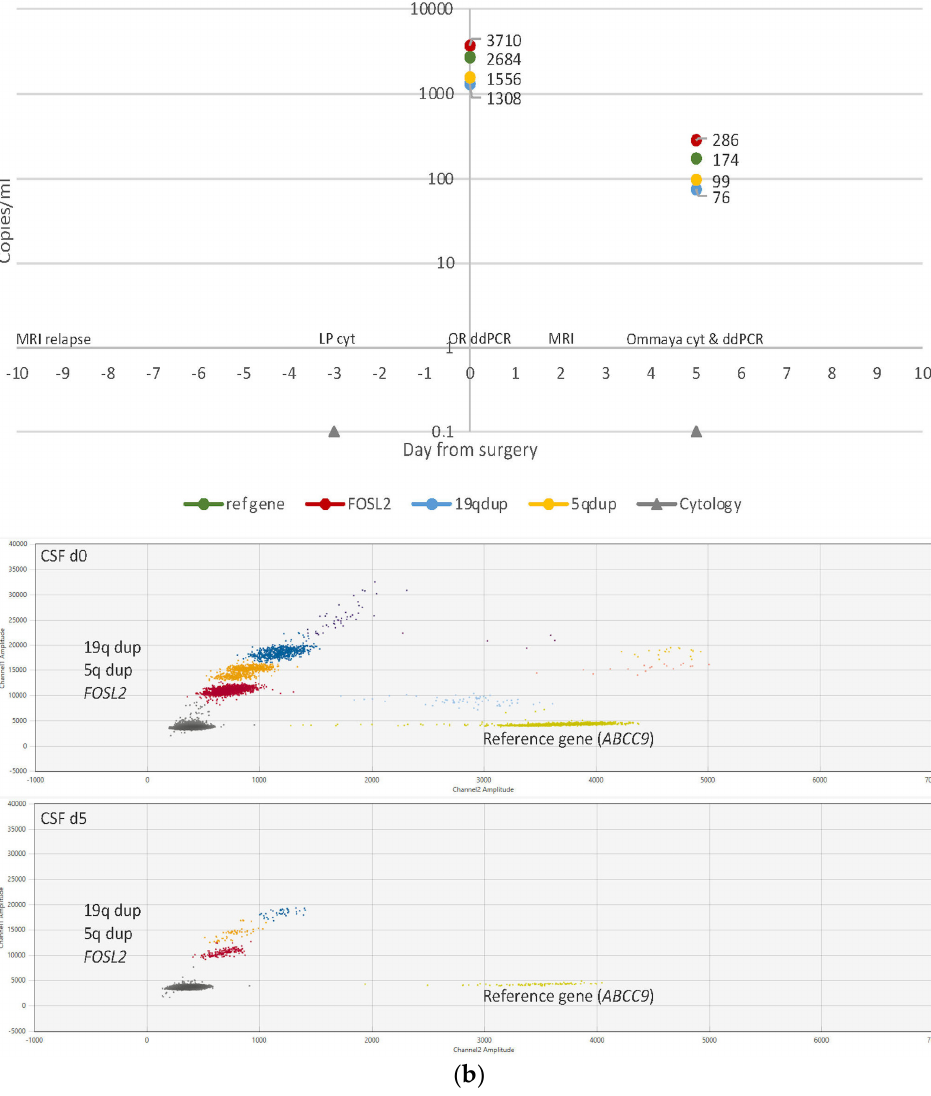
Figure 2. Timelines (top panels) with sampling time points and results from CSF ctDNA ddPCR and CSF cytology. 2D fluorescence amplitude plots (bottom panels) showing output data generated by the QX Manager™ Software (BioRad, USA). Y -axis, end-point FAM- fl uorescence from targets. X -axis, end-point HEX- fl uorescence from reference gene ( ABCC9 ). ( a ) Results for patient 1 on d0, prior to surgery, and d14 post-operatively. Targets: der(11)t(11;17) in purple, 5q dup/ SNCAIP in red, and both targets in blue. Empty droplets in grey, reference positive droplets in green. Double positives (target and reference) in multiple colors on the right-hand side of the plot: der(11) and reference in pink, 5q dup and reference in dark green, both targets and reference in orange ( b ) Results for patient 15 on d0, prior to surgery, and d5 post-operatively. Targets: FOSL2 c.383G>A in red, 5q13.3 tandem duplication in orange, and 19q12 tandem duplication in blue, and all targets in purple.. Empty drop- lets in grey, reference positive droplets in mustard. Double positives (target and reference) in mul- tiple colors on the right-hand side of the plot: FOSL2 and reference in light blue, 5q13.3 tandem dup and reference in pink, 19q12 tandem dup and reference in yellow, all targets and reference in wine.